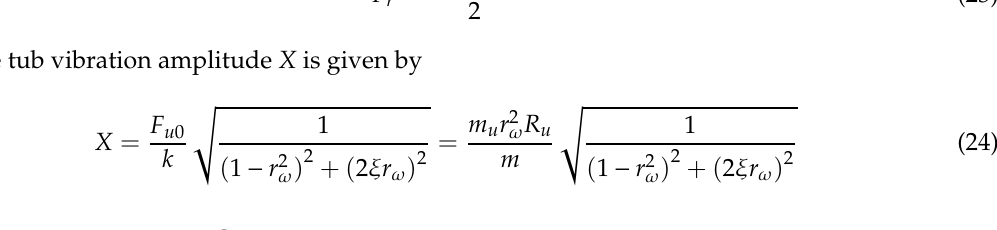
(cid:112) 1 − ξ 2 , the